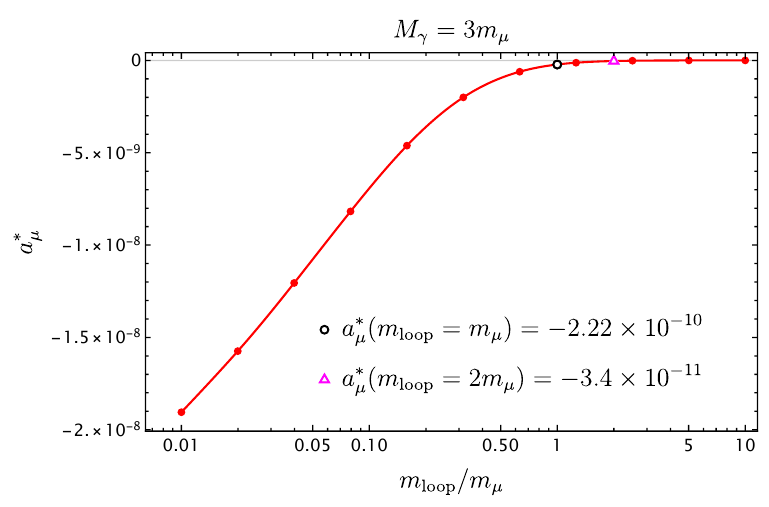
Figure 4 . Anomalous magnetic moment via the Cottingham formula without the counterterm to be compared with lattice QCD: varying the mass inside the VP. The cutoff scale is chosen to be Λ ≡ M γ = 3 m µ